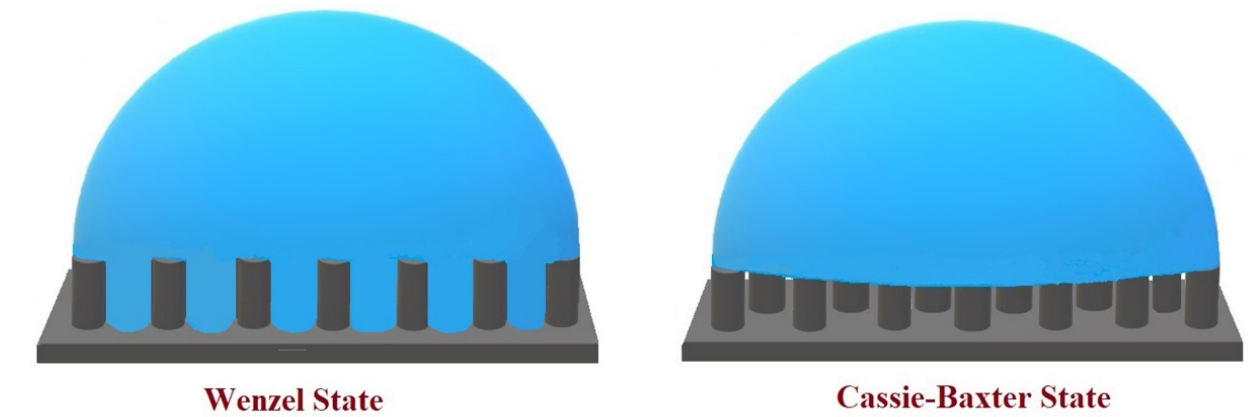
Figure 3. Schematic description of sessile droplets on patterned surfaces according to Wenzel and Cassie-Baxter states.